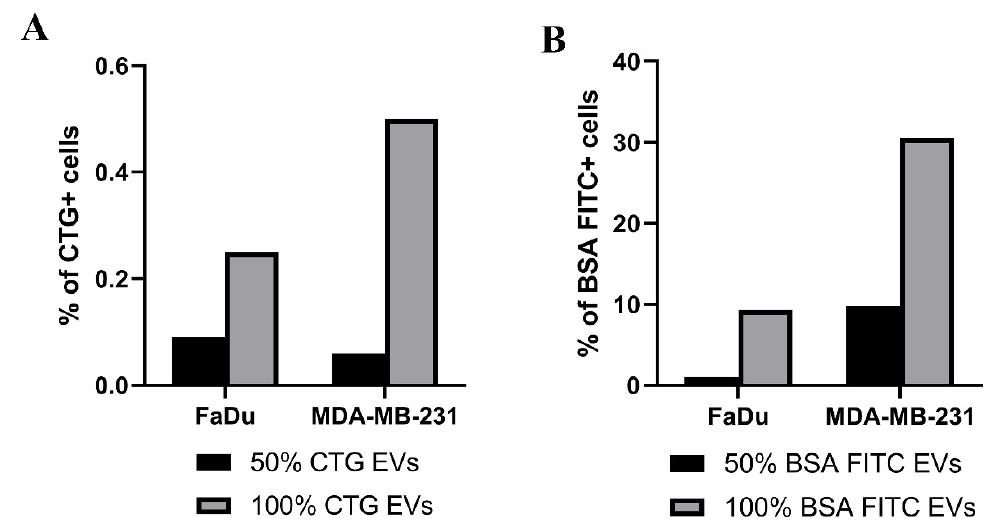
Figure 6. Uptake of EVs containing CTG or BSA-FITC by FaDu and MDA-MB-231 cells. EVs containing CTG ( A ) or BSA-FITC ( B ) at a concentration of 50% and 100% were co-cultured with FaDu or MDA-MB-231 cells for 4 h. The uptake of these EVs was measured by using flow cytometry. Percentages of FaDu and MDA-MB-231 cells exposing CTG or BSA FITC after EV uptake at 4 h-time point are presented ( A,B accordingly). Control conditions were cells co-cultured with EVs which contained no CTG or BSA FITC. Percentages of the positive cells have been corrected for their controls and the uptake of EVs was normalized to 1 × 10 9 particles/mL .